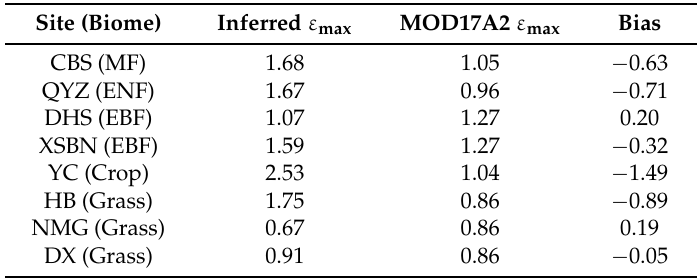
Figure 12. Eight-day tower estimated GPP (gC·m − 2 ·8-day –1 ) against the product of GLASS FPAR, tower PAR, VPD s and T s for: ( a ) Mixed forests; ( b ) Evergreen needleleaf forests; ( c ) Evergreen broadleaf forests; ( d ) Croplands; and ( e ) Grasslands. APAR (Absorbed Photosynthetic Active Radiation) = FPAR × PAR. Table 6. Comparison of the inferred ε max and MOD17A2 ε max at the eight sites. Site (Biome) Inferred ε max MOD17A2 ε